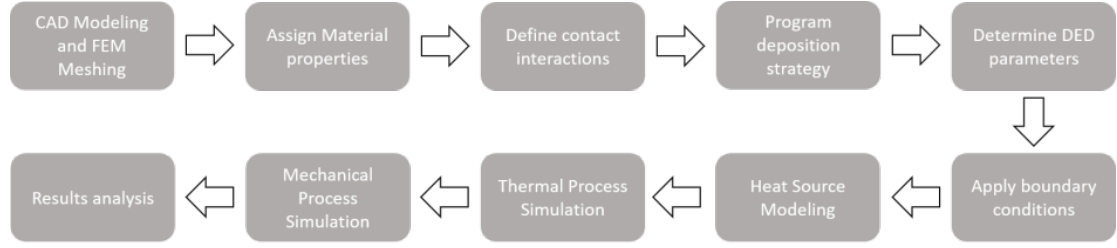
Figure 1. Flowchart of the proposed thermo – mechanical model.